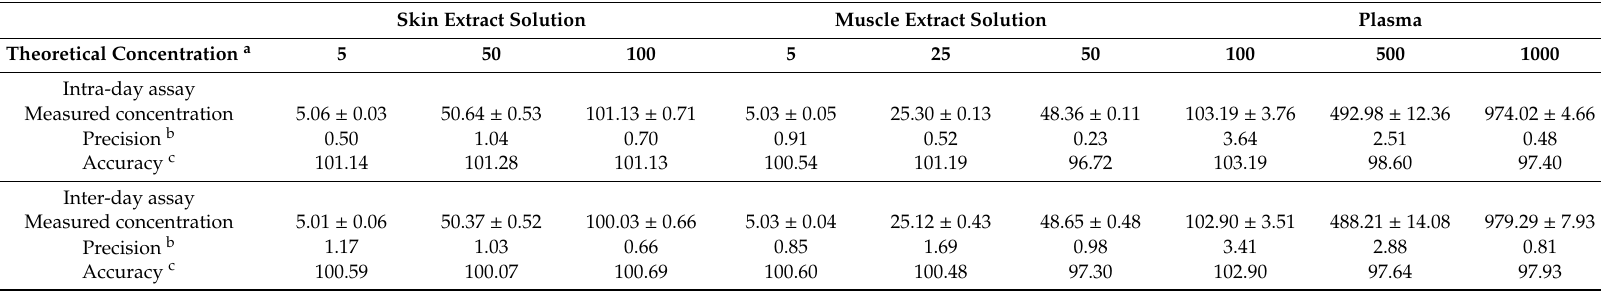
Table 2. Precision and accuracy values for the analytical method used to quantify FBF in porcine skin, rat muscle and rat plasma ( n = 3). Skin Extract